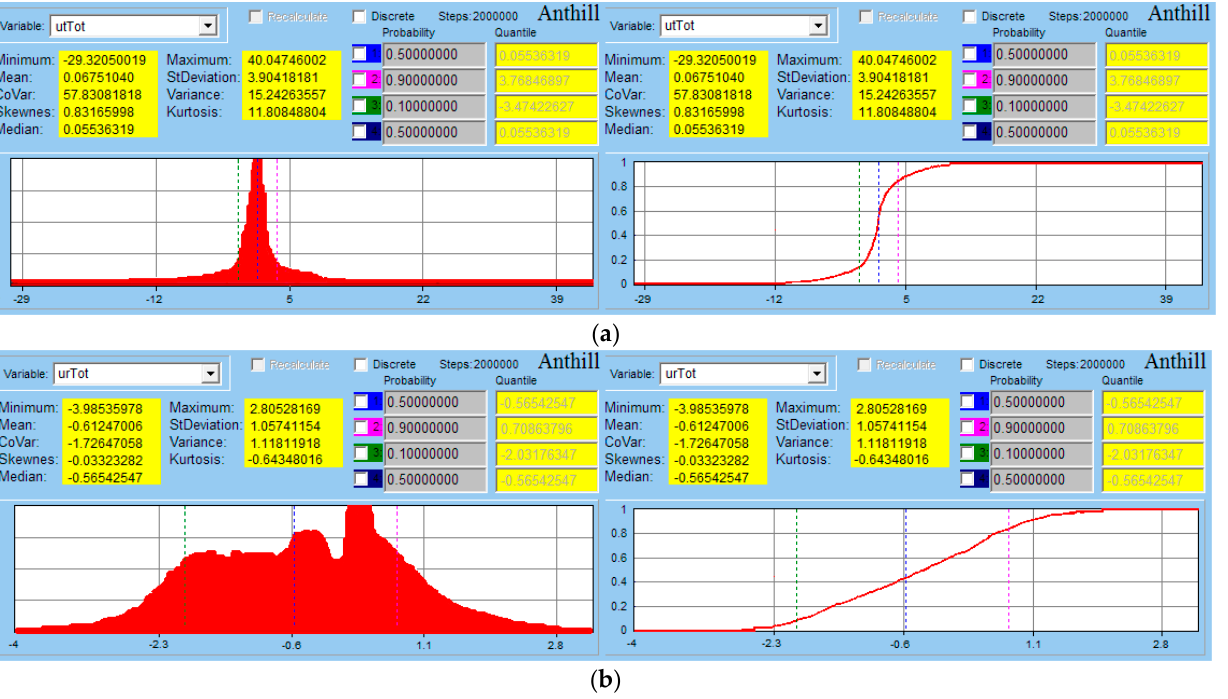
Figure 17. Histograms and distribution functions of ( a ) tangential component of total crustal surface displacement, ( b ) radial component of total crustal surface displacement (sw MSC.Marc Mentat and Anthill).